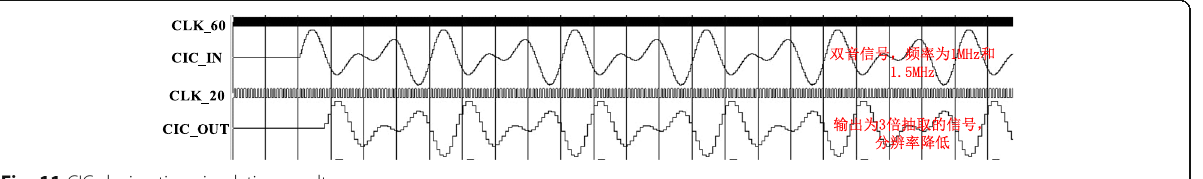
Fig. 11 CIC decimation simulation